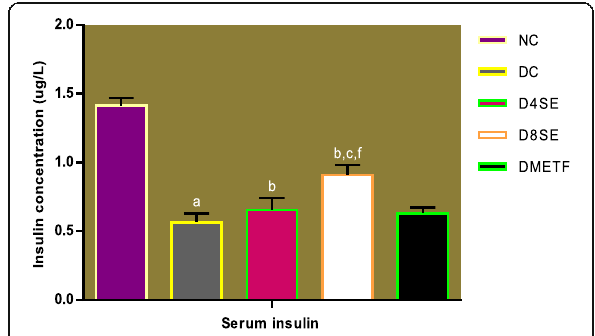
Fig. 5 Effect of SE and METF on serum insulin concentration in rats. Values are expressed as mean±SEM of 8 rats. NC=Normal control, DC=Diabetic control, D4SE=Diabetic animals treated with SE (400 mg\kg BW), D8SE=Diabetic animals treated with SE (800 mg\kg BW), DMETF=Diabetic animals treated with metformin (12 mg\kg BW). a=significant when compared to NC, b=significant when compared to DC, c=significant when compared D4SE d=significant when compared to D8SE, f=significant when compared to DMETF the administered doses (400 and 800 mg/kg BW) signifi- cantly raised the level of insulin in both serum and pan- creas relative to diabetic control rats. Compared to SE, treatment of diabetic rats with METF failed to signifi- cantly restore the level of insulin in both tissues.